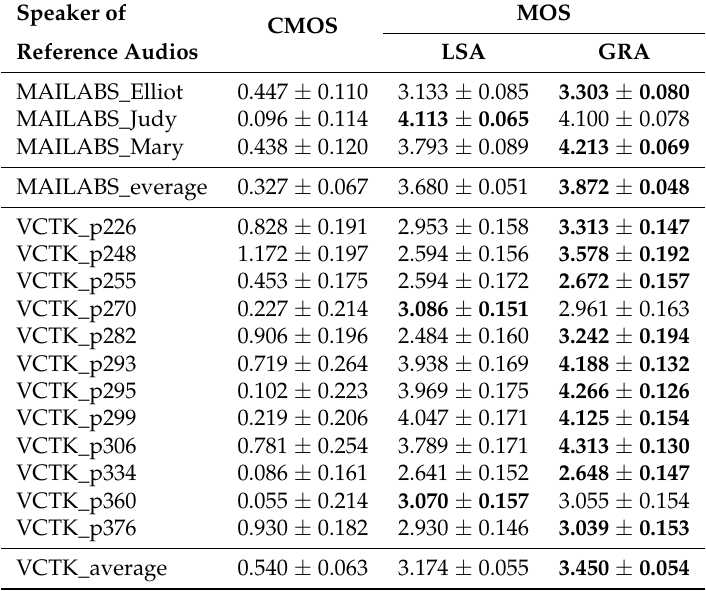
Table 3. Similarity CMOS and naturalness